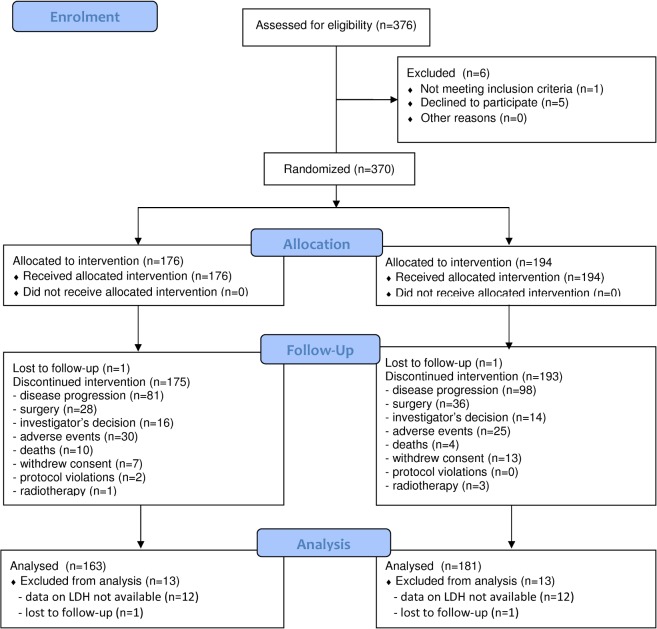
Consort flowchart.